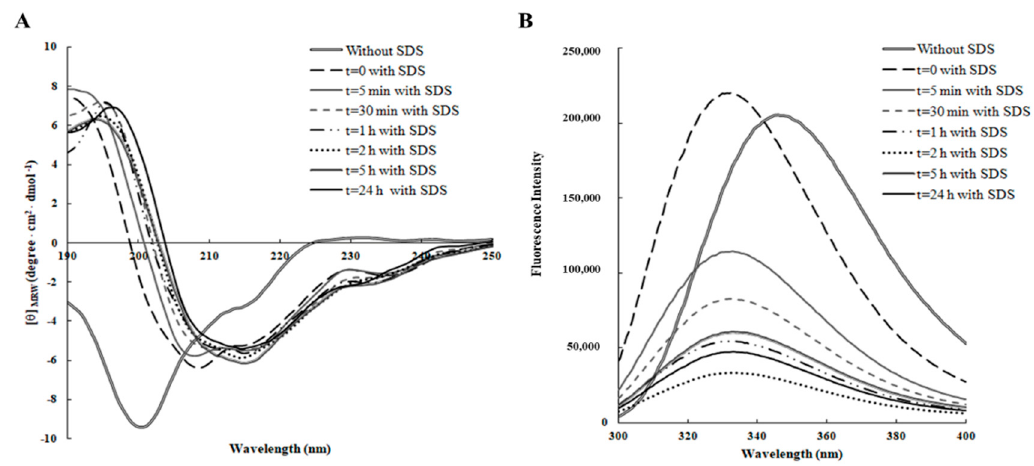
Figure 1. Time-dependent e ff ect of SDS on the secondary and tertiary structure of RiLK1 monitored by spectroscopic analyses. ( A ) Far-UV Circular Dichroism (CD) spectra of the peptide (0.1 mg / mL) Figure 1. Time ‐ dependent effect of SDS on the secondary and tertiary structure of RiLK1 were recorded in 10 mM Tris-HCl bu ff er pH 7.0 in the presence or absence of SDS (3 mM) over the time monitored by spectroscopic analyses. ( A ) Far ‐ UV Circular Dichroism (CD) spectra of the at 25 ◦ C. ( B ) Intrinsic fluorescence emission spectra of RiLK1 (0.1 mg / mL) in 10 mM Tris-HCl bu ff er, peptide (0.1 mg/mL) were recorded in 10 mM Tris ‐ HCl buffer pH 7.0 in the presence or absence pH 7.0 in the presence or absence of SDS (3 mM) over the time at 25 ◦ of SDS (3 mM) over the time at 25 °C. ( B ) Intrinsic fluorescence emission spectra of RiLK1 (0.1 mg/mL) in 10 mM Tris ‐ HCl buffer, pH 7.0 in the presence or absence of SDS (3 mM) over the time at 25 °C.